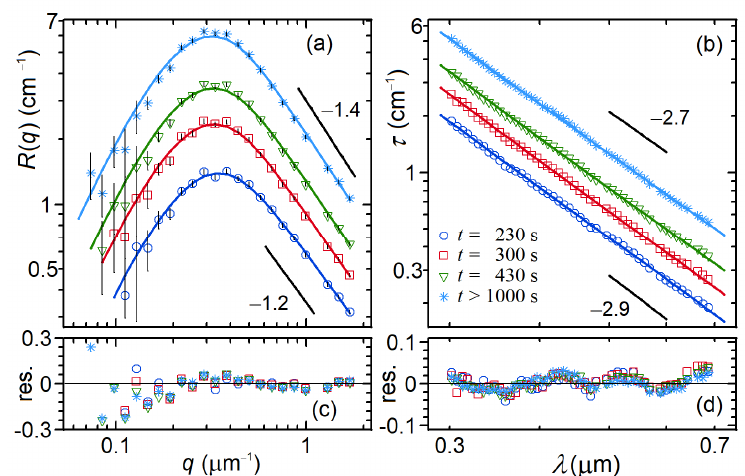
Figure 10. LAELS ( a ) and turbidity ( b ) data taken on a polymerizing fibrin solution (FG 0.45 mg/mL in TBE, THR:FG molar ratio 1 ÷ 100) at different, relatively long times after adding thrombin to the FG solution. Continuous lines through the data represent the fittings carried out with the two steps procedure described in the text. Panels ( c , d ) report the corresponding relative residuals for each fit. Pictures reproduced with permission from Ref. [14].